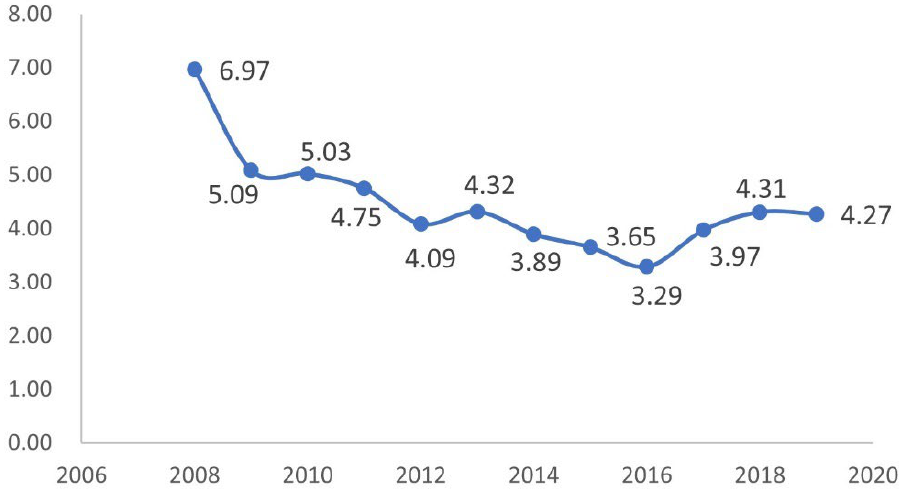
Figure 2. 2008–2019 Water footprint population density in Tarim River basin. Unit: Persons/10 4 t. Data source: According to the statistical yearbook of Xinjiang.